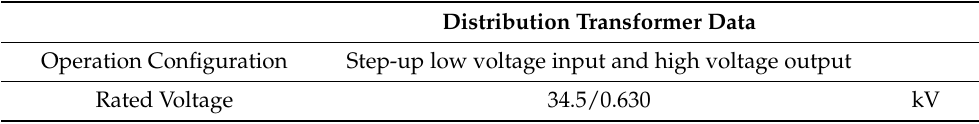
Table A2. Distribution transformer required